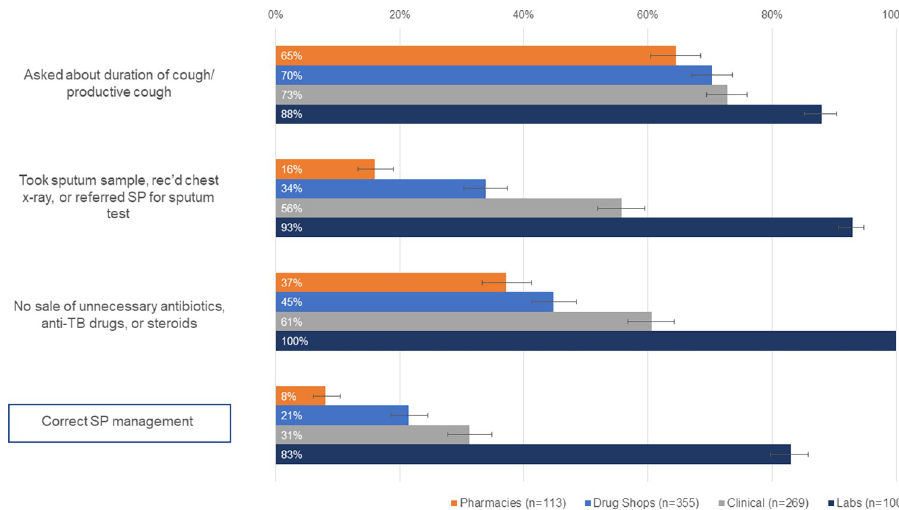
Fig 1. Case 1: Management of SPs presenting as presumptive patients, by facility